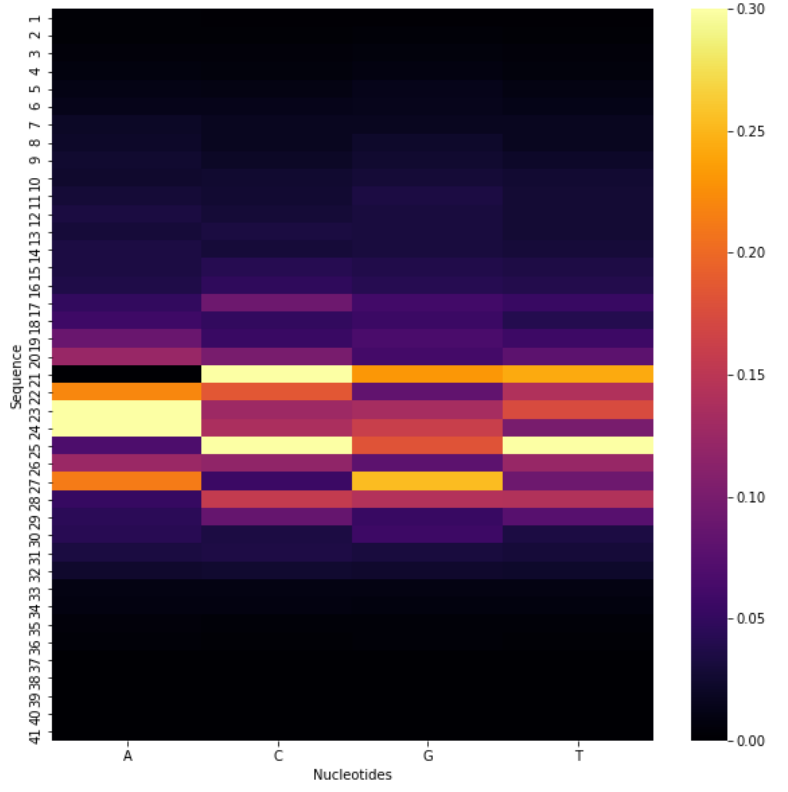
Figure 4. Heat Map to study the effect of mutation in model